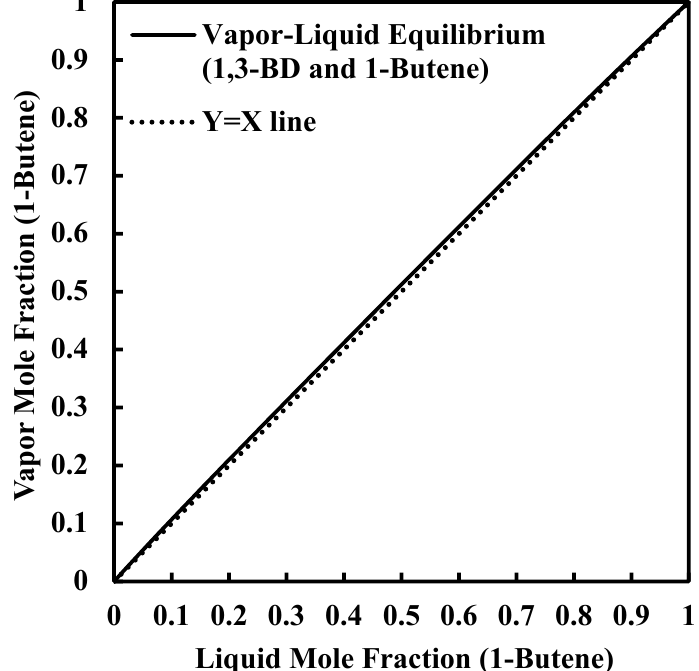
Figure 2. Vapor-liquid equilibrium curve of 1,3-BD and 1-butene .